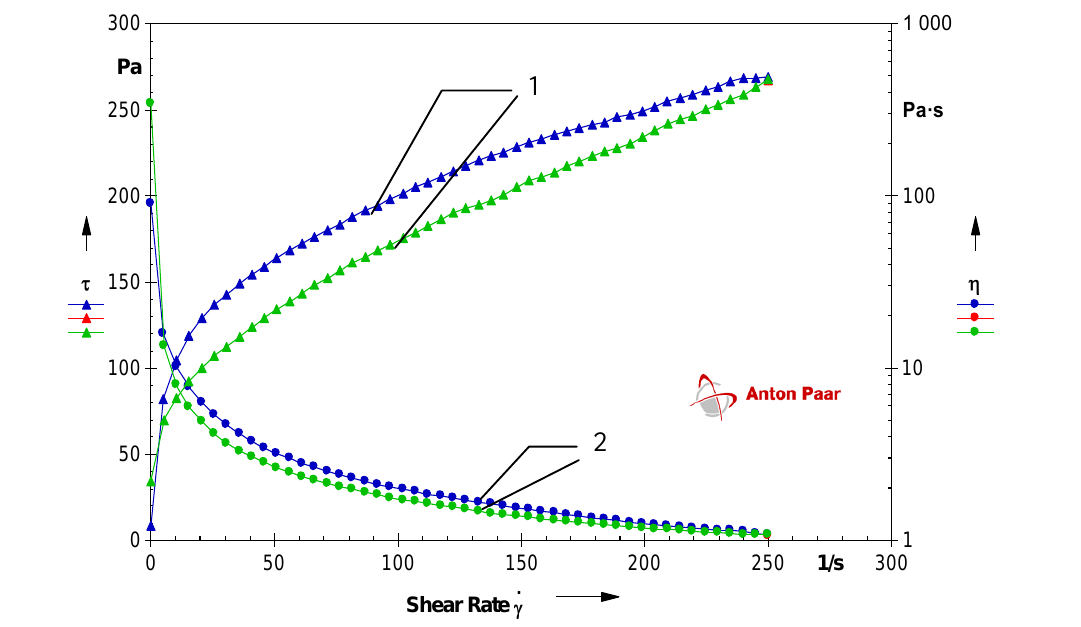
Рис. 2. Реограма зразку гелю з 2 %